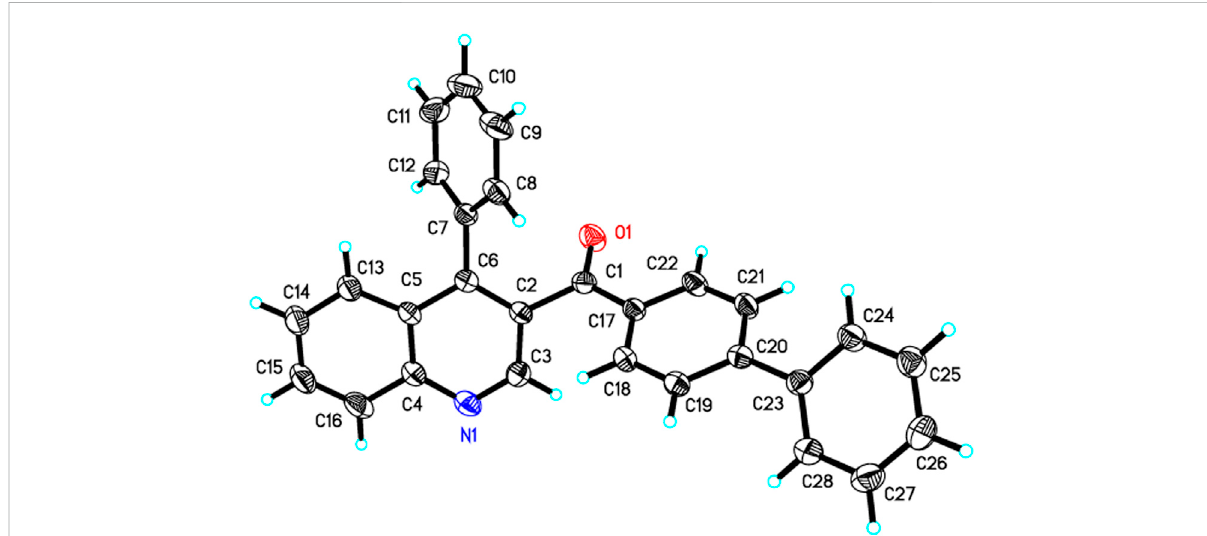
FIGURE 1 X-ray diffraction structure of